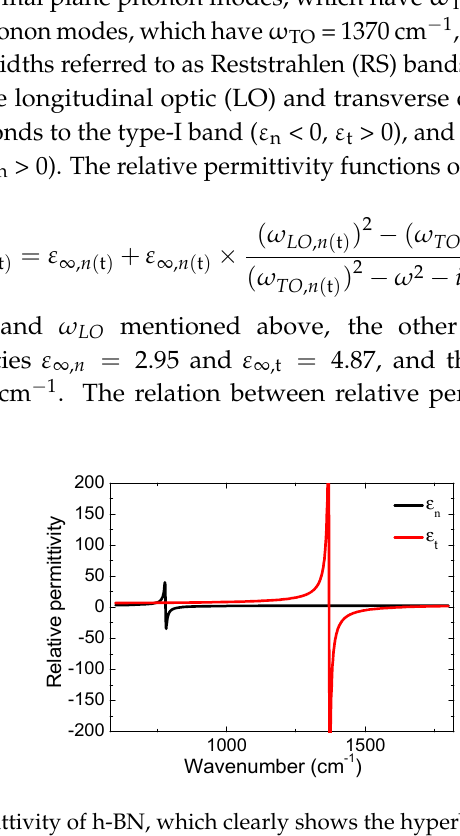
Figure 1. Relative permittivity of h-BN, which clearly shows the hyperbolicity in the two RS bands.